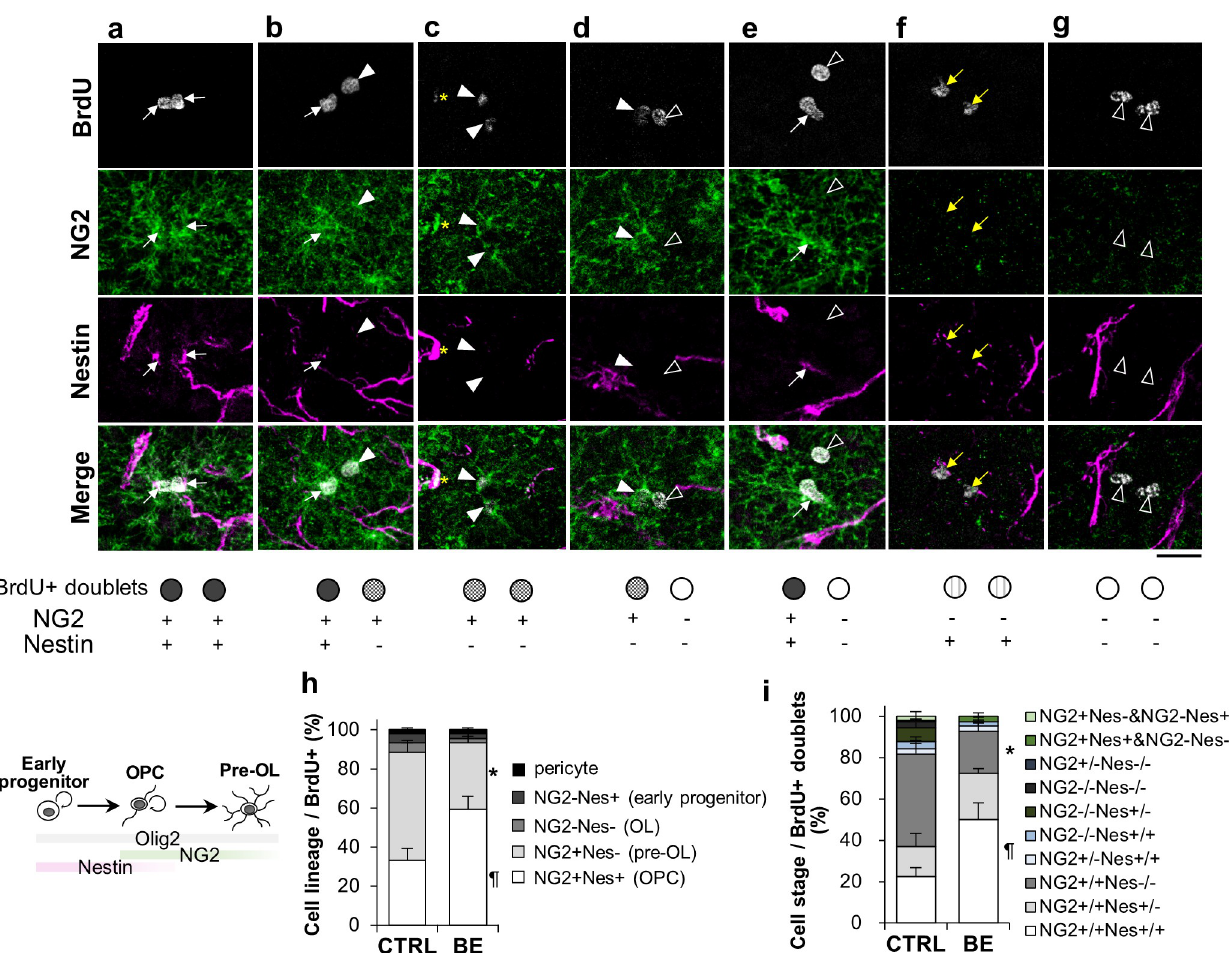
Fig 4. Cell stage progression of proliferated cells at P25. ( a-g ) Confocal images of BrdU+ (gray) sister cells co-immunostained with antibodies against NG2 (green) and Nestin (magenta) in bin 8. Shown are representative images of BrdU+ doublets: NG2+/+Nestin+/+ ( a ), NG2+/+Nestin+/- ( b ), NG2 +/+Nestin-/- ( c ), NG2+/-Nestin-/- ( d ), NG2+Nestin+ & NG2-Nestin- ( e ), NG2-/-Nestin+/+ ( f ), and NG2-/-Nestin-/- ( g ). Arrows and arrowheads indicate as follows: NG2+Nestin+ (white arrow), NG2+Nestin- (closed white arrowhead), NG2-Nestin- (open white arrowhead), and NG2-Nestin+ (yellow arrow). Yellow asterisks indicate NG2 and Nestin-colabeled pericytes. Scale bar, 20 μ m. Schematic diagram is given on the left to show the definition of putative OL lineage cell types based on possible expression patterns during cell stage progression. ( h ) The proportion of NG2 and/or Nestin expressing singlet cell types among BrdU-labeled cells. Presumptive cell types are indicated in the parentheses. For CTRL vs. BE, one-way ANOVA and Tukey-Kramer post hoc test, F (1, 8) = 7.89, � p = 0.023, F(1, 8) = 7.49, ¶p = 0.026. ( i ) Proportional analysis of BrdU+ doublets. For CTRL vs. BE, N = 5 per group, one-way ANOVA and Tukey-Kramer post hoc test, F(1, 8) = 8.28, � p = 0.021, F(1, 8) = 9.28, ¶p = 0.016.